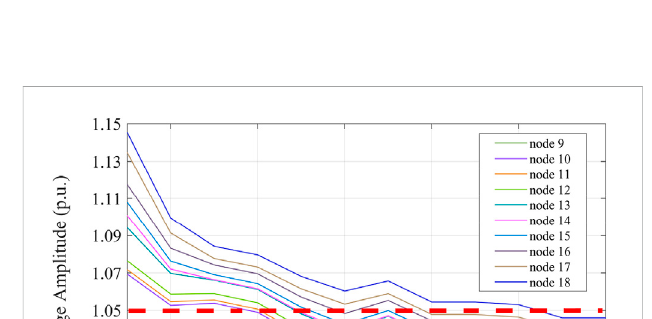
FIGURE 13 Voltage control effect in the case of no active power